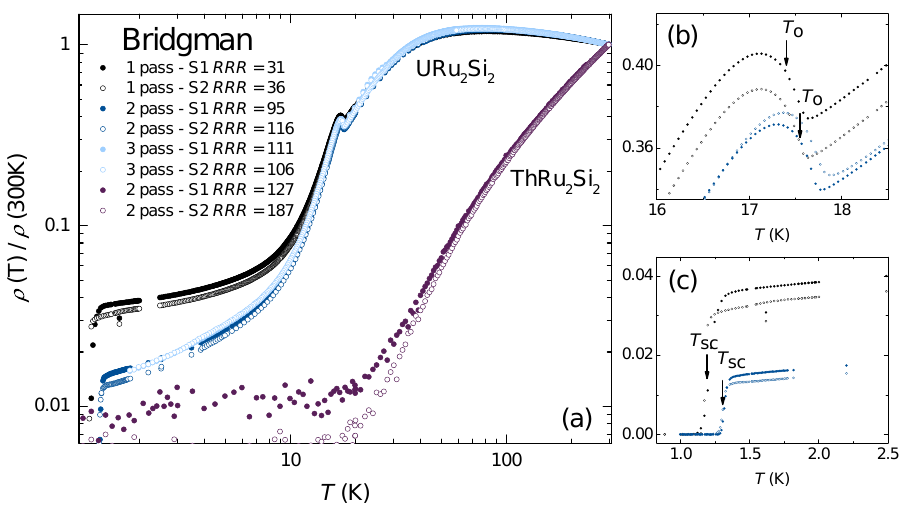
Figure 3. ( a ) Electrical resistivity ρ normalized to the value at room temperature ρ 300K vs. temperature T for several specimens from two different batches. The typical room temperature resistivities are ρ 300K ≈ 450 µ Ω · cm and 100 µ Ω · cm for URu 2 Si 2 and ThRu 2 Si 2 , respectively. Differences in growth parameters for the batches are shown in Table 1; ( b ) ρ 300K / ρ 0 vs. T near the hidden order transition T 0 . The width of the transition is defined from the minimum (onset of kink) to the peak, with the midpoint indicated by the arrow; ( c ) ρ / ρ 300K vs. T near the superconducting transition. The width of the transition is defined as onset and termination of the step, with the midpoint indicated by the arrow.